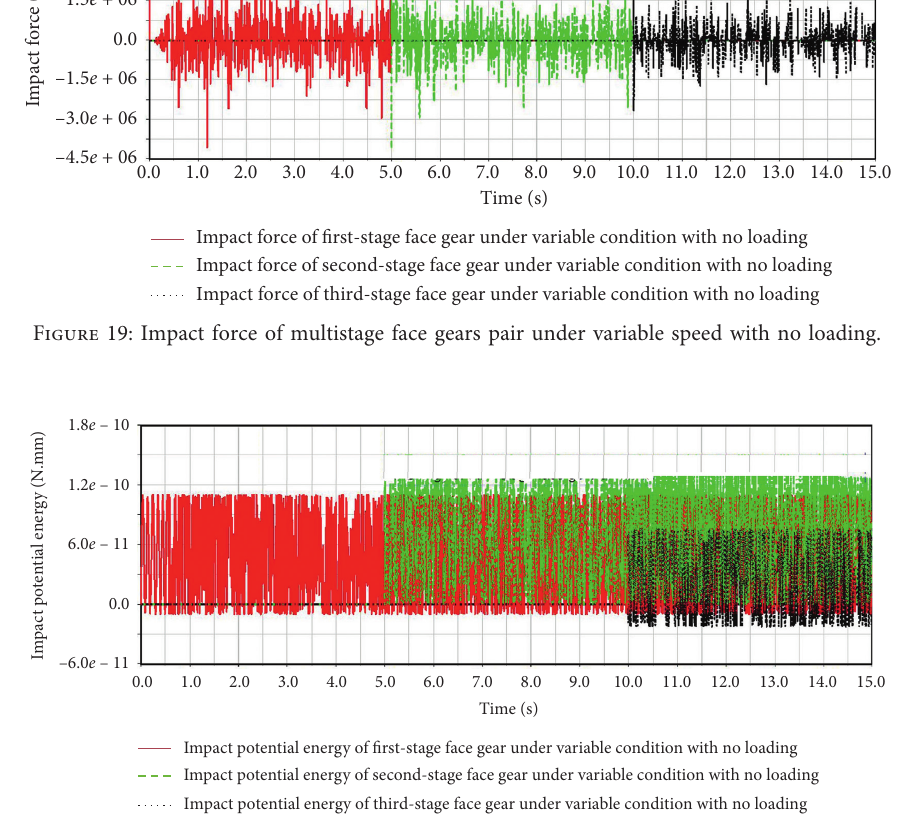
Figure 20: Impact potential energy of multistage face gears pair under variable speed with no loading.